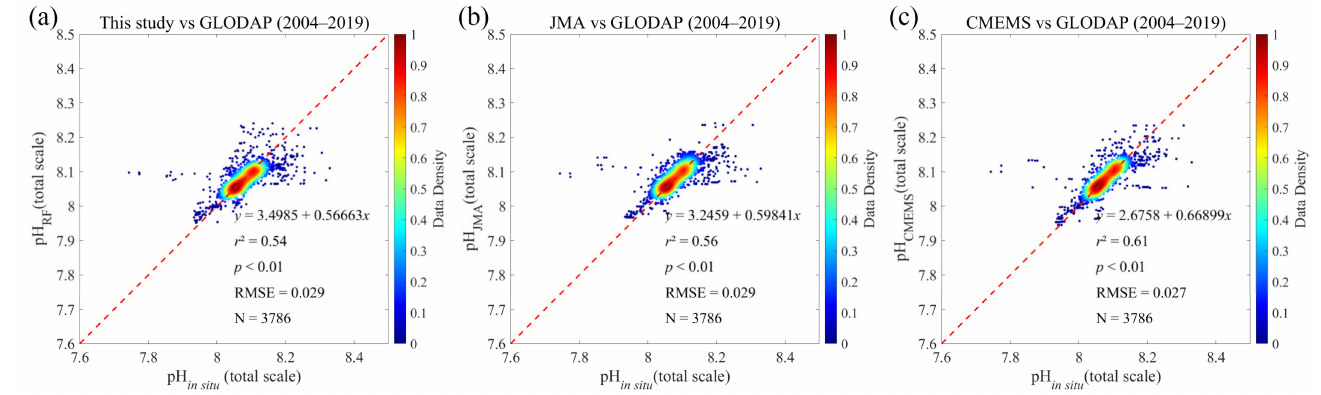
Figure 17. Scatter plot between satellite-derived pH and the in situ pH: ( a ) is pH product in this study, ( b ) is pH product from JMA, ( c ) is pH product from